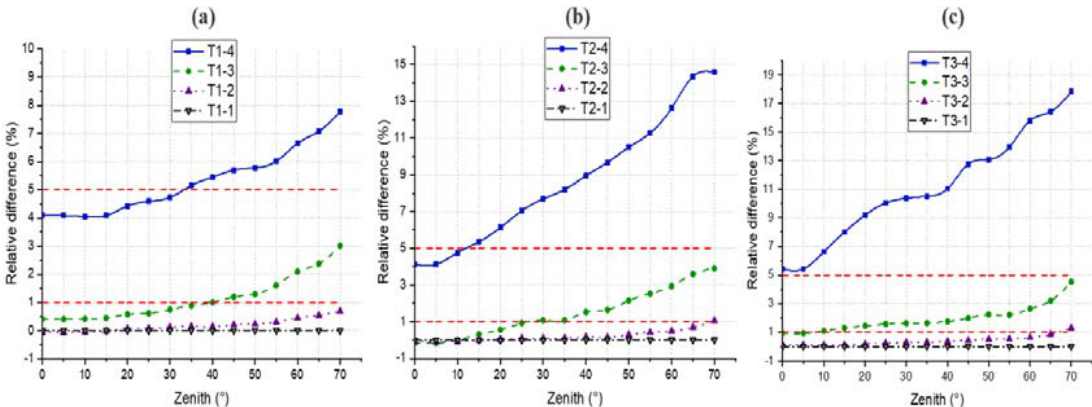
Figure 12. Relative difference of gap fraction (East direction), ( a ) first stage, ( b ) second stage, and ( c ) last stage. The dashed lines in red show the relative difference of 1% and 5%.